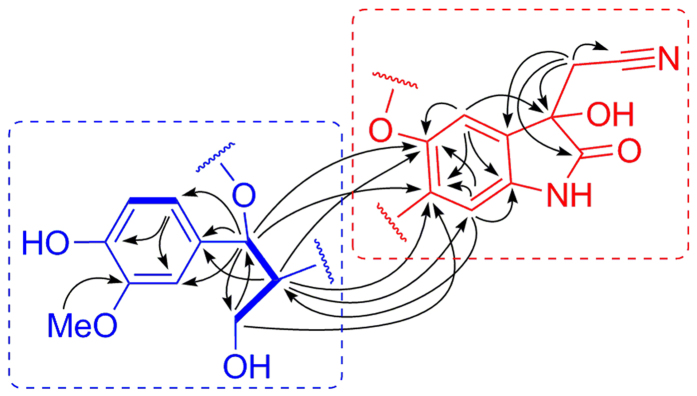
Key 1H–1H COSY (─) and HMBC (H→C) correlations of 1.